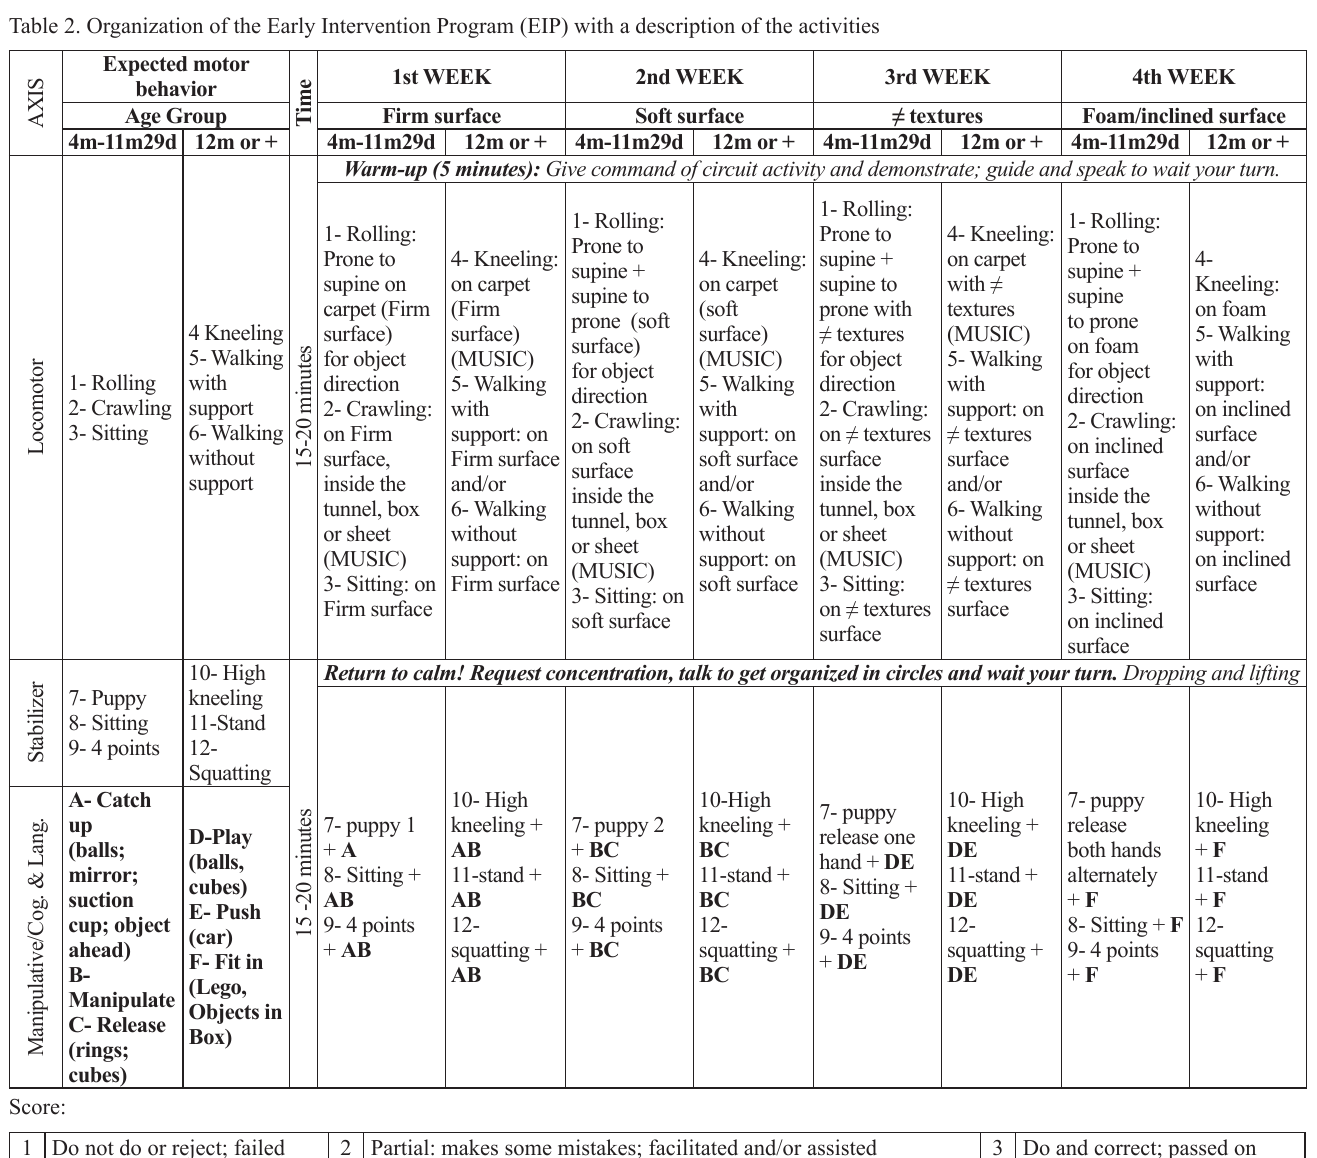
Table 2. Organization of the Early Intervention Program (EIP) with a description of the activities